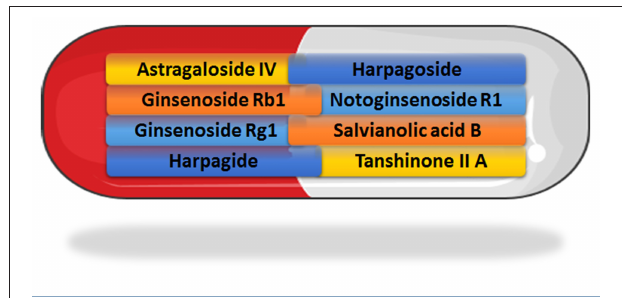
FIGURE 2 | Recently identified constituents of Fufang Xue Shuan Tong (FXST) identified using liquid chromatography–tandem mass spectrometry (Zhou et al., 2015). (Capsule image adapted and reproduced with permission from the copyright holder